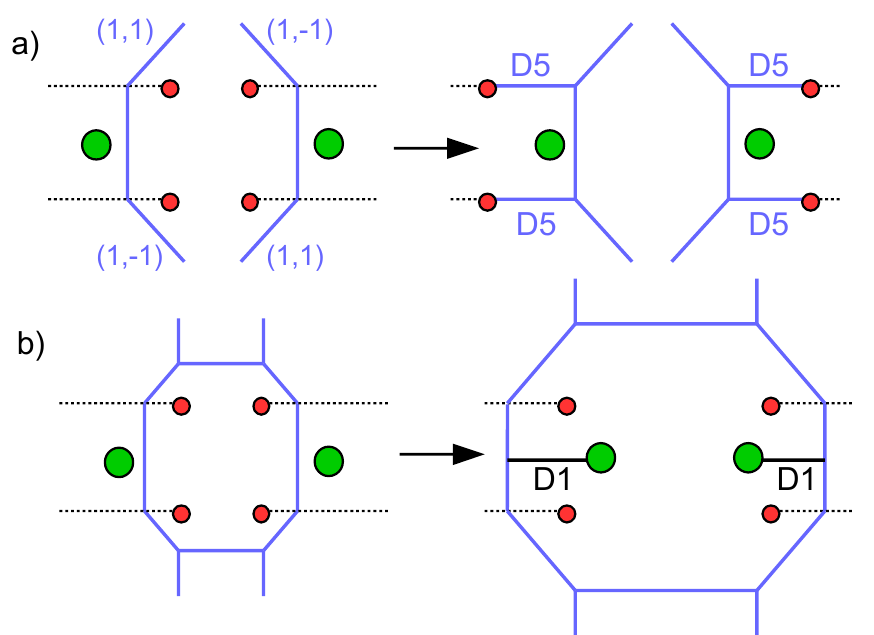
Figure 5 . a) Brane setup for L 1 taking into account the e(cid:11)ect of the D7-branes on the NS5 branes, here with four D7 branes, for the N f = 4 SU(2) theory. b) Completion of the 5-brane web to resolve